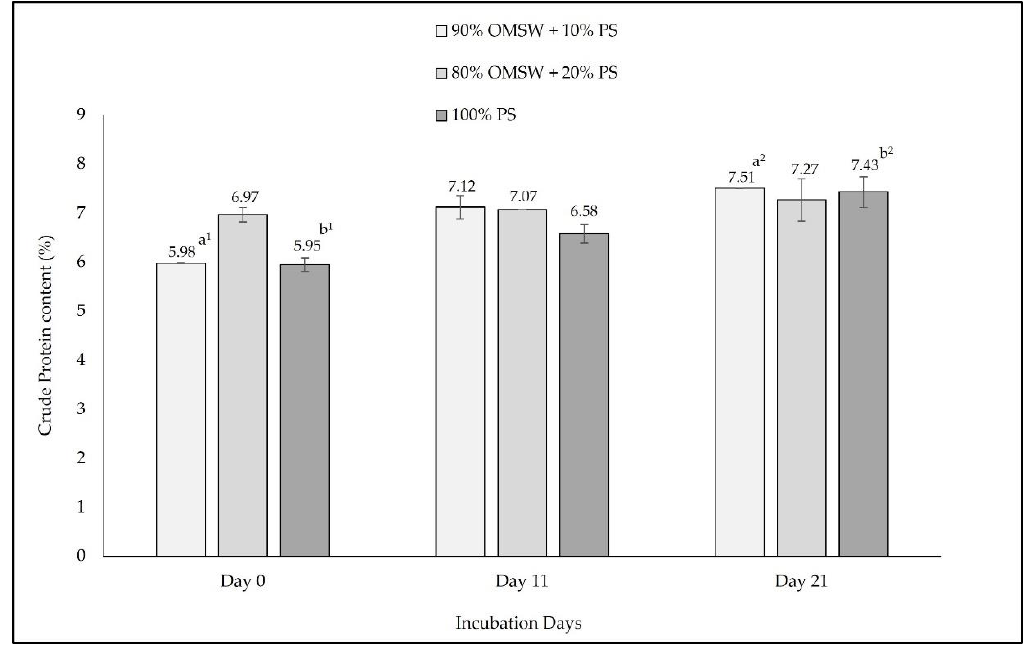
Figure 2. Evaluation of crude protein content (%) for PS and its mixtures with OMSW. Statistical analysis was performed for each substrate individually between Day 0 and Day 21. Different super- scripts between the same letters indicate statistical significance ( p ≤ 0.05).